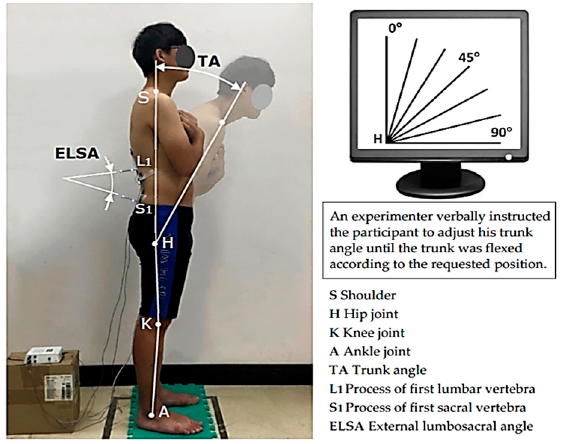
Figure 2. Schematic of marker locations and body angles utilized in this study.